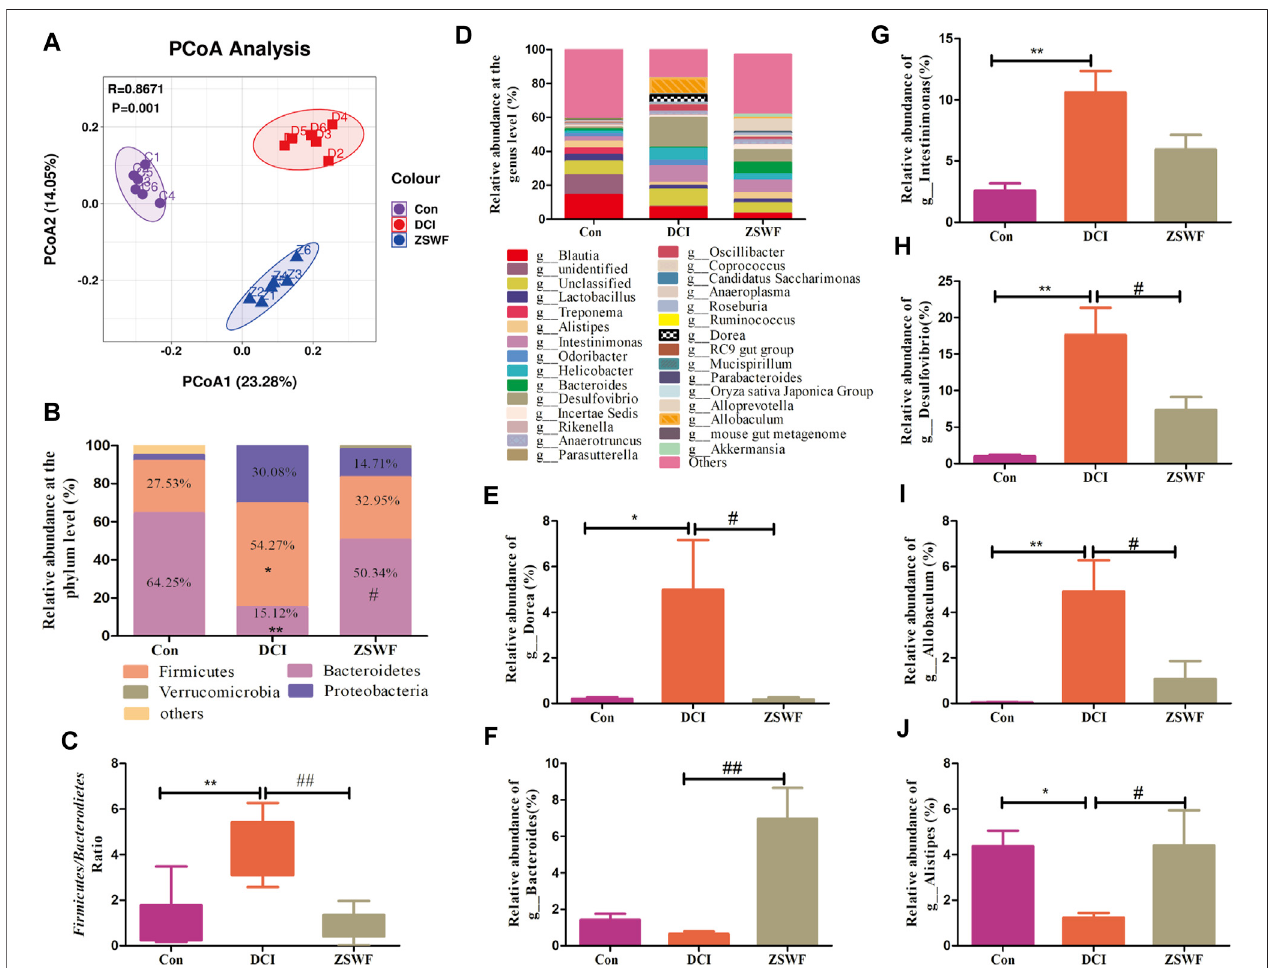
FIGURE 4 | ZSWF reversed gut microbiota dysbiosis in DCI mice. (A) principal coordinates analysis (PcoA), (B) relative abundances at phylum levels, (C) ratio of Firmicutes to Bacteroidetes, (D) relative abundance of bacteria at the genus level, (E – J) relative abundance of Dorea , Bacteroides , Intestinimonas , Desulfourbrio , Allobaculum ,and Alistipes .Alldatawereexpressedasmean±SD( n =6),andone-wayANOVAwasusedtocomparestatisticaldifferencesbetweengroups,** p < 0.01, * p < 0.05 vs. Con group, ## p < 0.01, # p < 0.05 vs. DCI group.